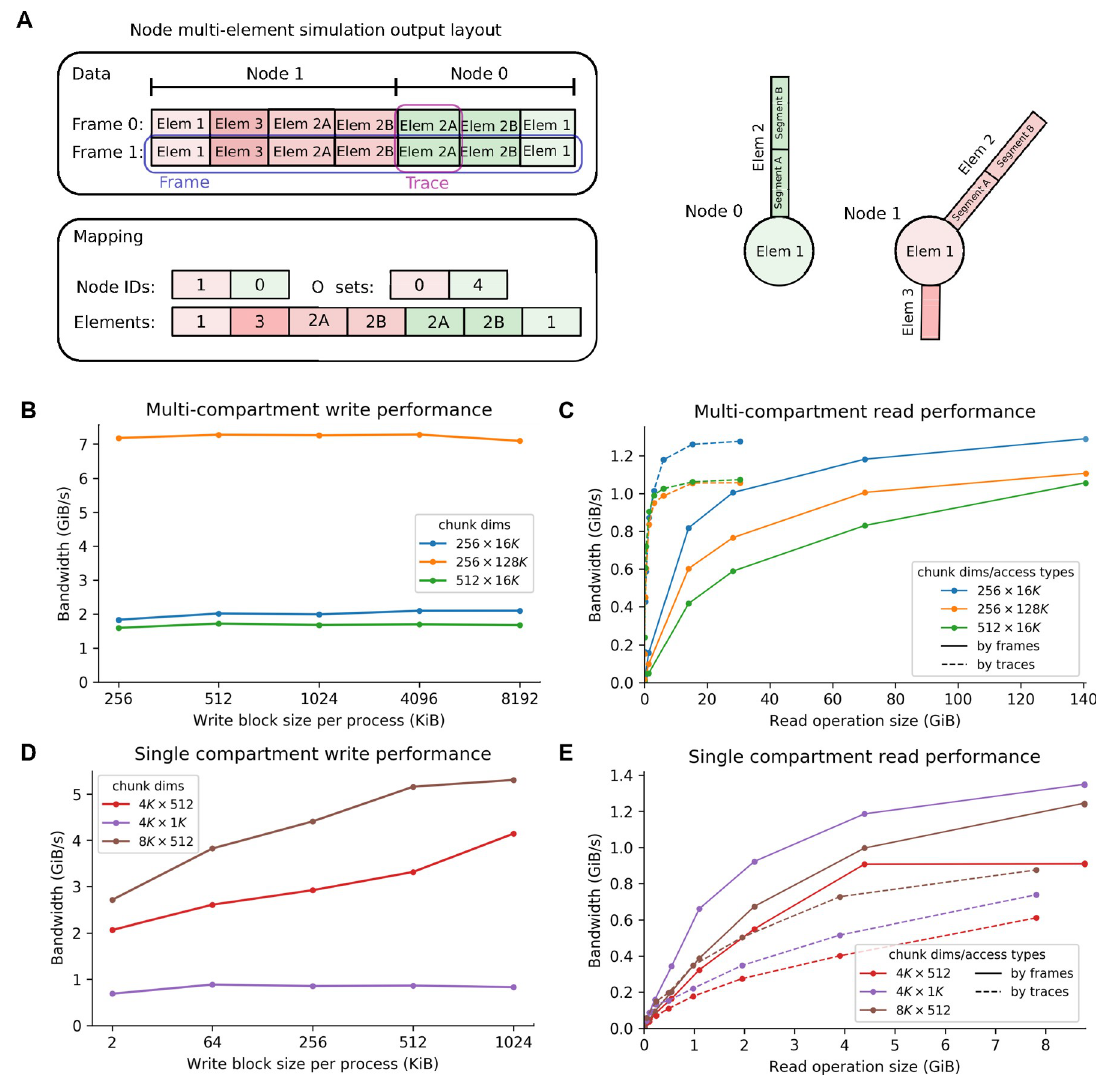
Fig 3. Recordings of activity in SONATA format. (A) Layout of a multi-compartment report. The dataset is a matrix where each frame (set of values at one point in time) is a row and columns represent traces (the time series of all values associated with one element). All the elements of a node are contiguous within a frame, but nodes may not appear sorted by ID. The position of the first element of each node is indicated by the offset array. Elements can be divided into multiple parts (e.g. morphological sections with multiple electrical compartments). (B-E) Examples of read/write performance (see Methods ). Write performance (B, C) and read performance (D, E) of multi-compartment reports (B and D) and single compartment reports (C and E) is measured as bandwidth (amount of data written/ read per time unit). Three different HDF5 chunk dimensions (specified in the legend as N × M, where N refers to frames and M refers to traces; note that the K suffix indicates multiplication by 1024) were evaluated to demonstrate that high effective bandwidth can be obtained. In the reading evaluation, data was read by frames (continuous lines) and by traces (dotted lines) in single operations of different sizes to demonstrate the flexibility and high performance of the SONATA format; in the writing evaluation, data was only written by frames (continuous lines), which imitates the way most simulators generate